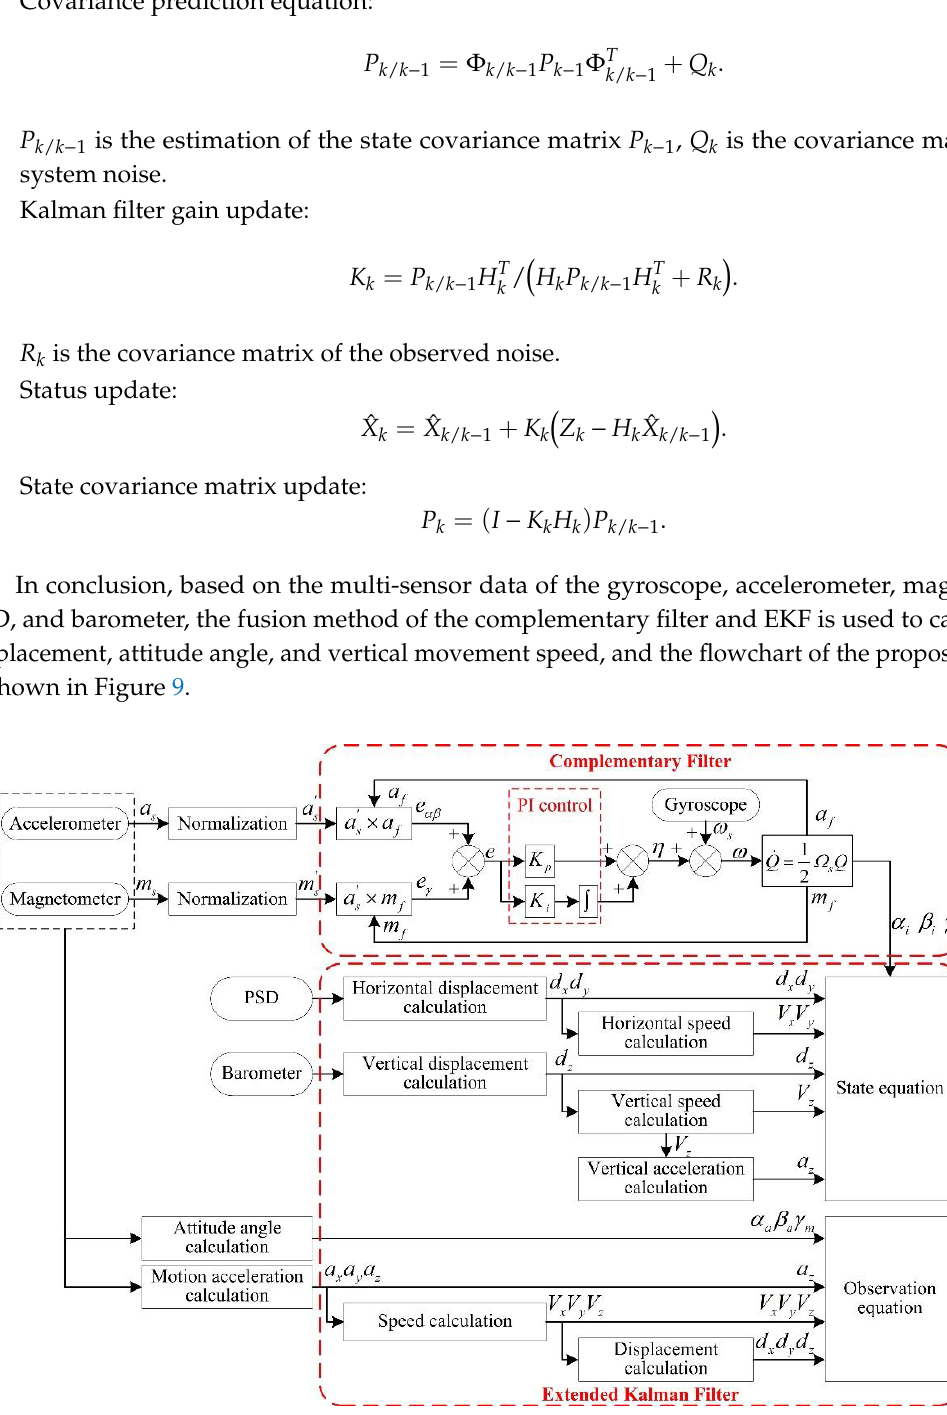
Figure 9. Flowchart of the proposed method combining the complementary filter with the extended Kalman filter (EKF).